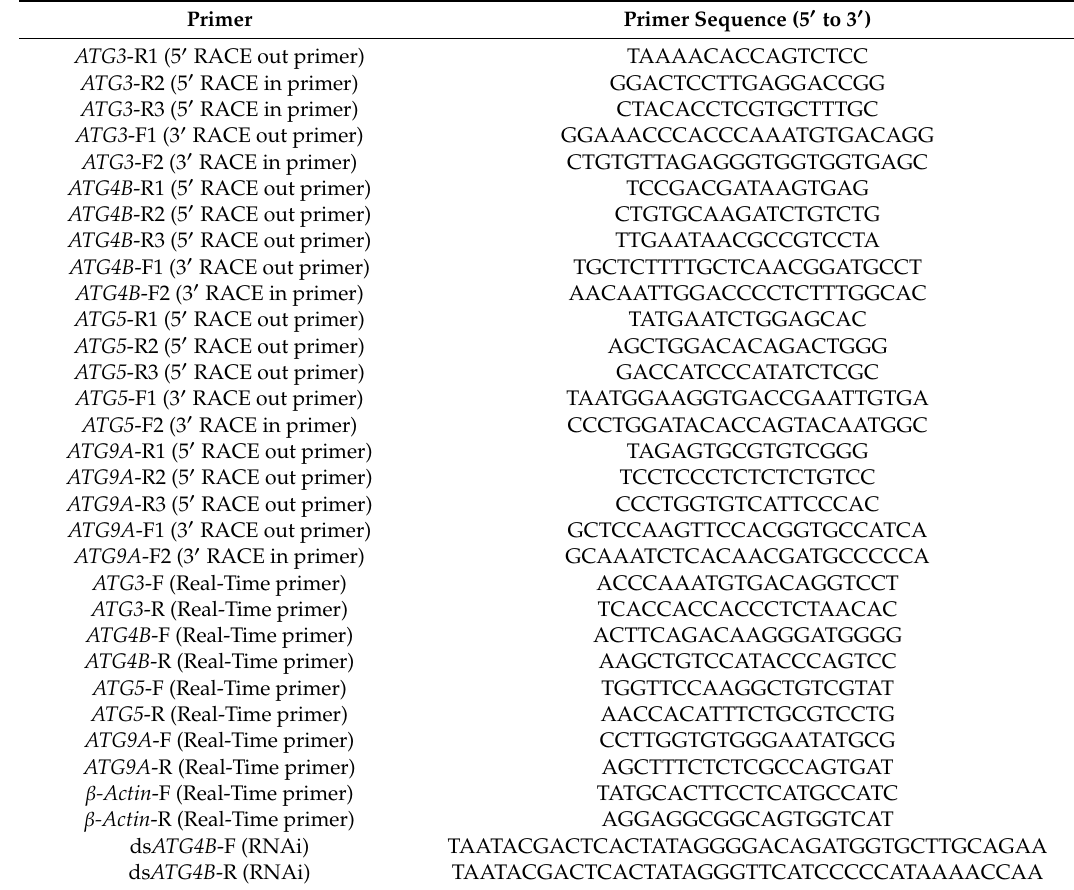
Table 1. Primers used in this